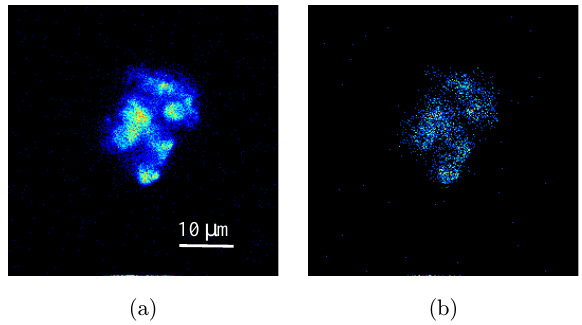
Fig. 5. SHG images of urea crystals dispersed in a scattering silicone resin sample at 1.2mm depth acquired by the trans- PMT (a) and epi-PMT (b).